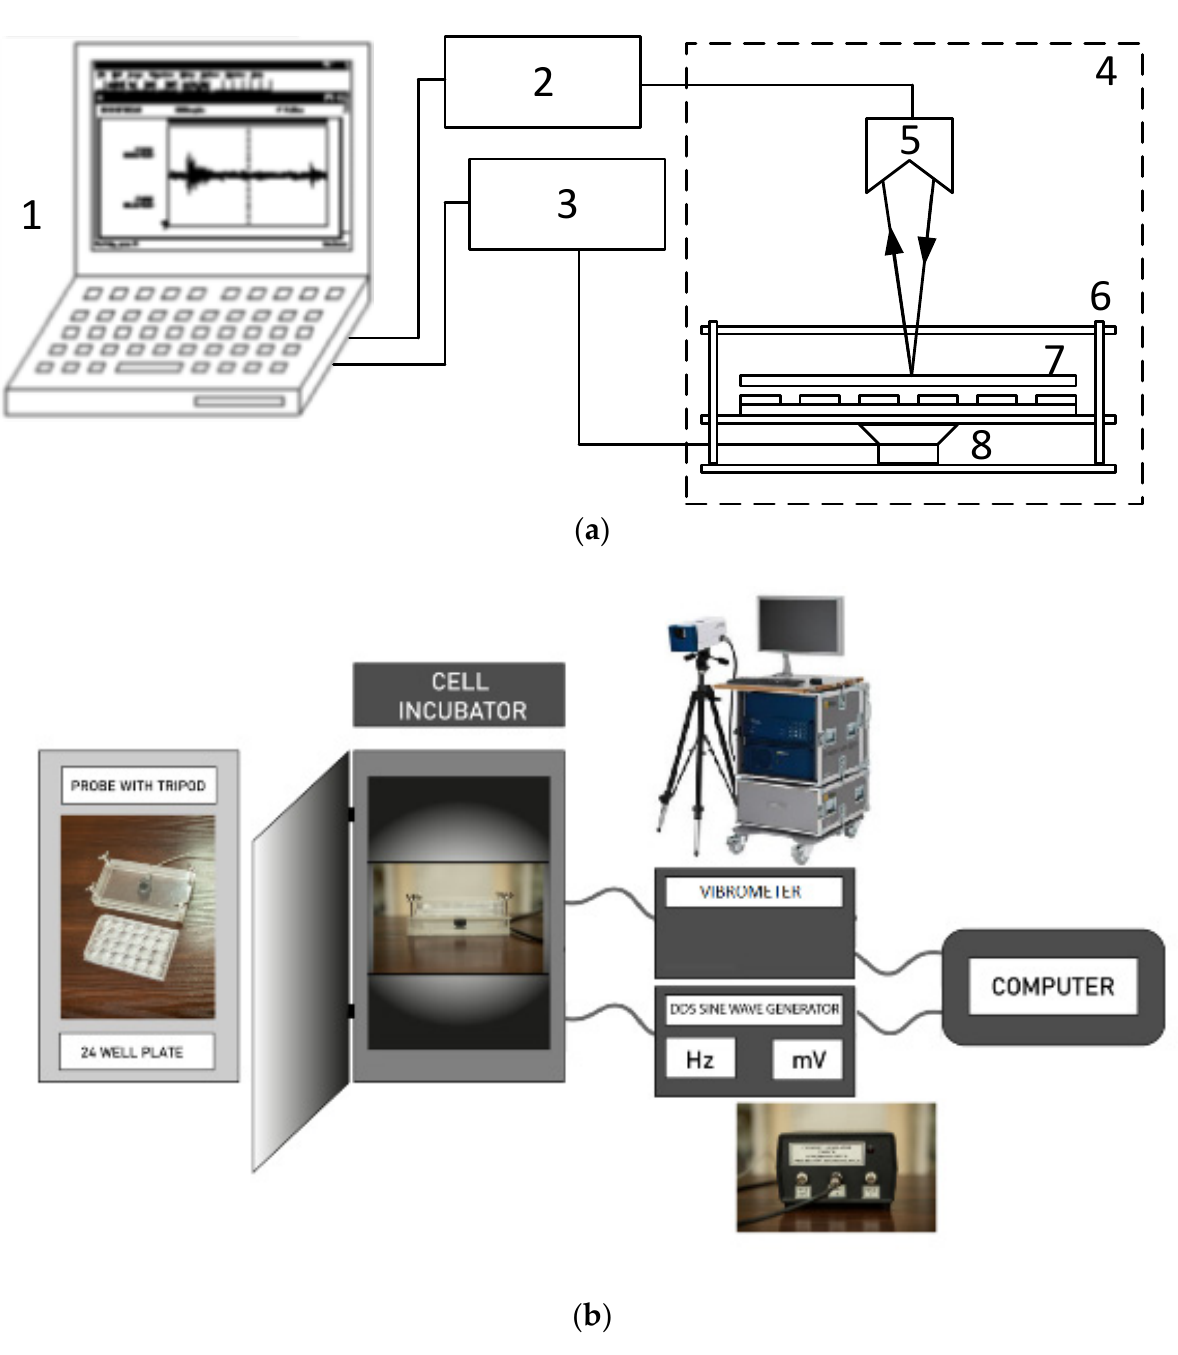
Figure 7. ( a ) Laboratory stands for the generation and measurement of nanoscale vibrations.